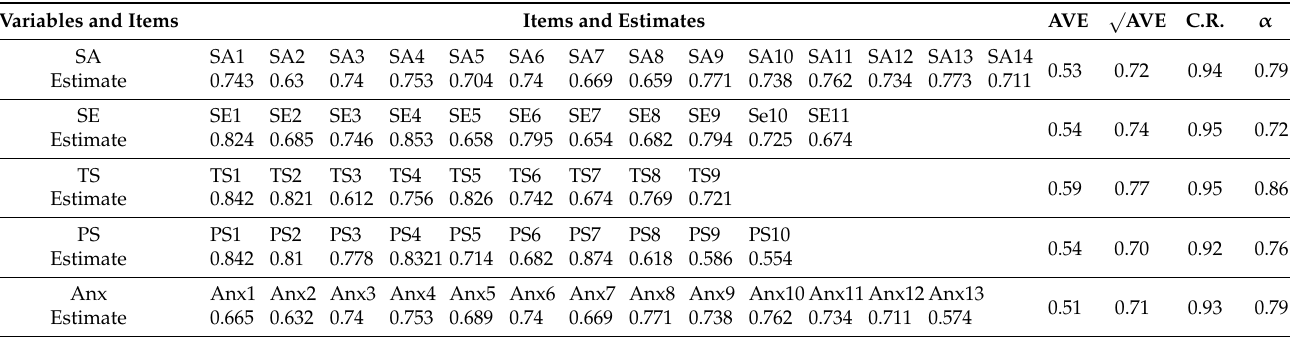
Table 2. Validation of